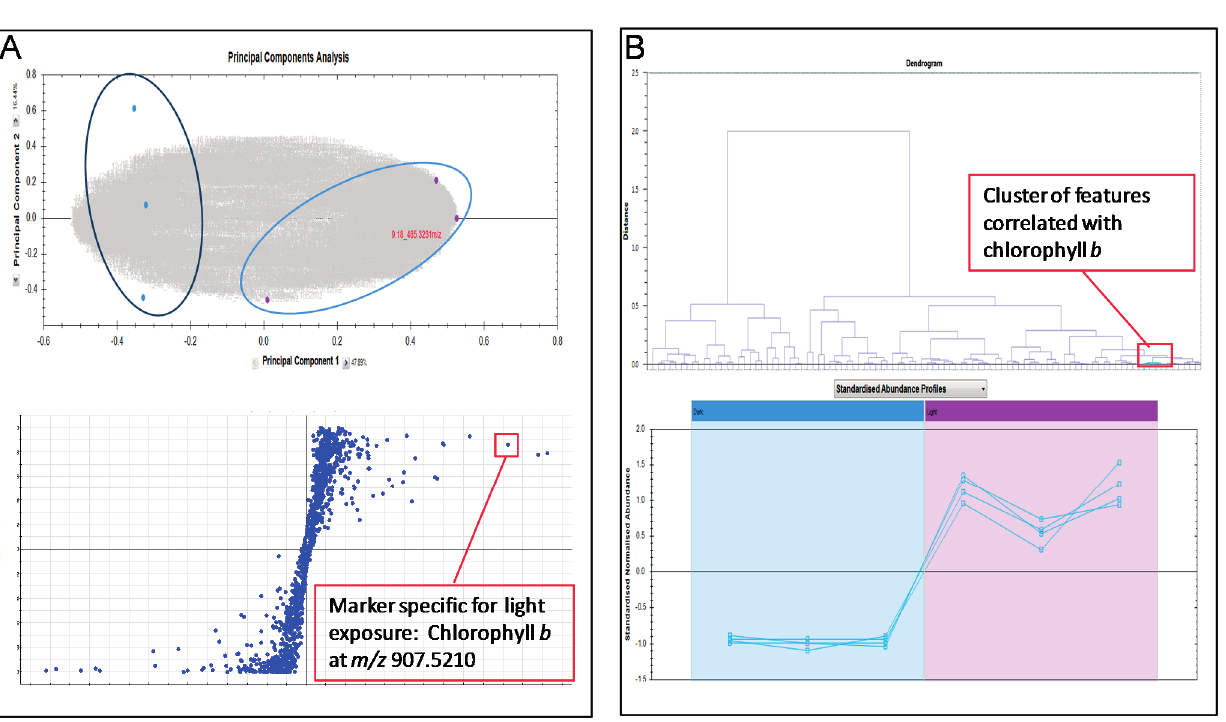
Figure 2. ( A ) Multivariate statistical analysis of the UPLC/HDMS E runs allowed separating samples into clusters using PCA. The metabolites that contributed most to the variance among groups were isolated using least-squares discriminant analysis (PLS-DA; bottom left); ( B ) Correlation analyses helped to identify similar patterns of alterations among metabolites. A representative example is showed for the metabolite with m / z 907.5210, which is increased in the light exposed samples and was then identified as chlorophyll b